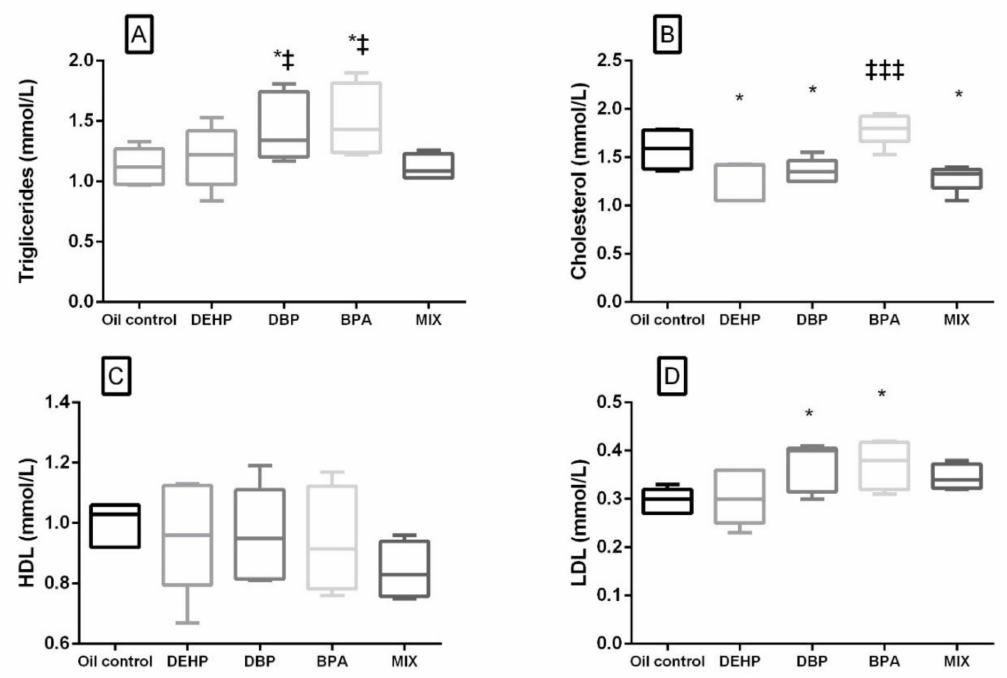
Figure 3. Lipid profile after 28 days of oral exposure to single investigated substances (DEHP, DBP, and BPA) and their mixture (MIX). Each box plot represents interquartile range (25–75th percentile), the line within the box represents median value, and ends of the whiskers represent the minimum and maximum values within the group. ( A ) Triglycerides (mmol / L), ( B ) cholesterol (mmol / L), ( C ) HDL (mmol / L), ( D ) LDL (mmol / L). * p < 0.05 (compared to the control), ‡ p < 0.05, ‡‡‡ p < 0.001. (compared to the MIX